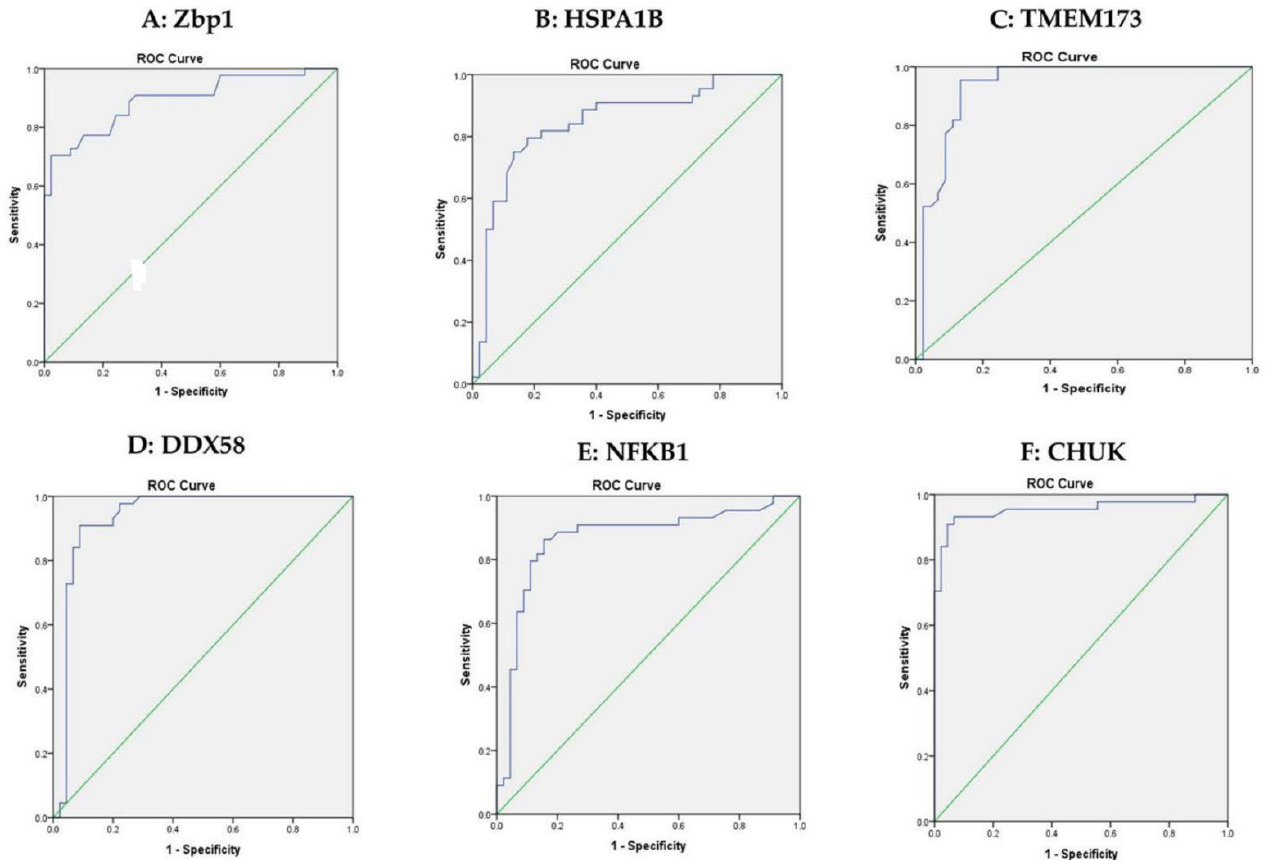
Figure 4. ROC curve analysis for the 6 mRNAs to discriminate healthy controls and the pre-DM group. ( A ): ROC curve analysis for serum Zbp1 used to calculate the best cutoff point to discriminate healthy controls from pre-DM. The best cutoff point for Zbp1 was ≥ 1.600 (sensitivity = 88.6%, specificity = 71.7%). ( B ): ROC curve analysis for serum HSPA1B used to calculate the best cutoff point to discriminate between healthy controls and the pre-DM group. The best cutoff point for HSPA1B was ≥ 2.341 (sensitivity = 81.8%, specificity = 77.8%). ( C ): ROC curve analysis for serum TMEM173 used to calculate the best cutoff point to discriminate between healthy controls and the pre-DM group. The best cutoff point for TMEM173 was ≥ 1.800 (sensitivity = 95.5%, specificity = 86.7%). ( D ): ROC curve analysis for serum DDX58 used to calculate the best cutoff point to discriminate between healthy controls and the pre-DM group. The best cutoff point for DDX58 was ≥ 1.220 (sensitivity = 97.7%, specificity = 77.8%). ( E ): ROC curve analysis for serum NFKB1 used to calculate the best cutoff point to discriminate between healthy controls and the pre-DM group. The best cutoff point for NFKB1 was ≥ 1.580 (sensitivity = 88.6%, specificity = 80%). ( F ): ROC curve analysis for serum CHUK used to calculate the best cutoff point to discriminate between the healthy controls and pre-DM. The best cutoff point for CHUK was ≥ 2.050 (sensitivity = 93.2%, specificity = 93.3%).